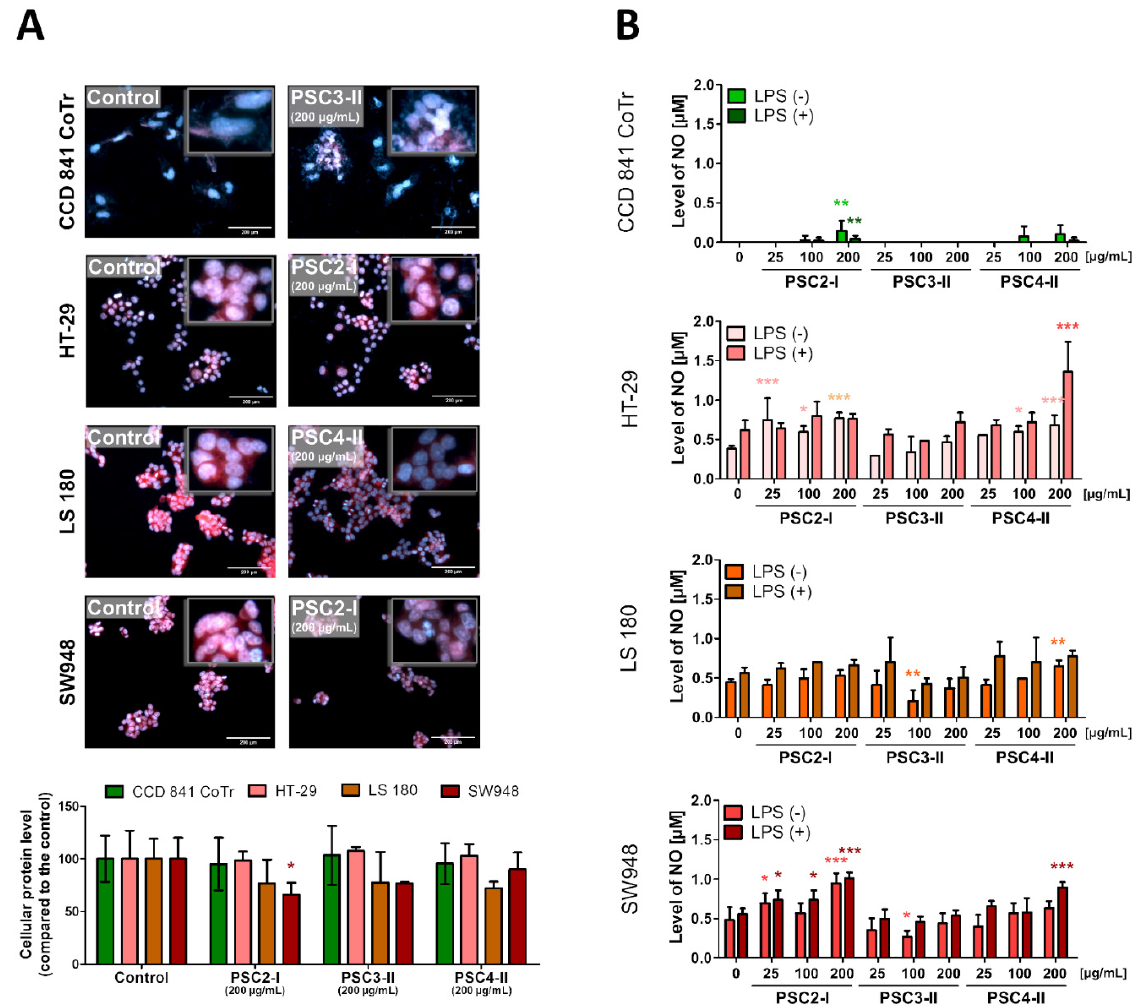
Figure 4. Anti-cancer effect of the PSC2-I, PSC3-II, and PSC4-II extracts on CCD 841 CoTr, HT-29, LS 180, and SW948 cells: ( A ) effect on the morphology of the cells and level of proteins measured with DAPI/SR101 staining (upper panel; the measurement bars indicate 200 µm; for all images, see supplementary material Figure S3) and level of the cellular proteins determined through measurement of the red fluorescence intensity (bottom panel) after incubation with extracts at 200 µg/mL; ( B ) concentration of NO secreted by the cells exposed to the studied extracts measured with the Griess method (exact concentrations are presented in supplementary material Tables S2-S4); * p < 0,05, ** p < 0,01, *** p < 0,005, one-way ANOVA, Dunnett’s test.